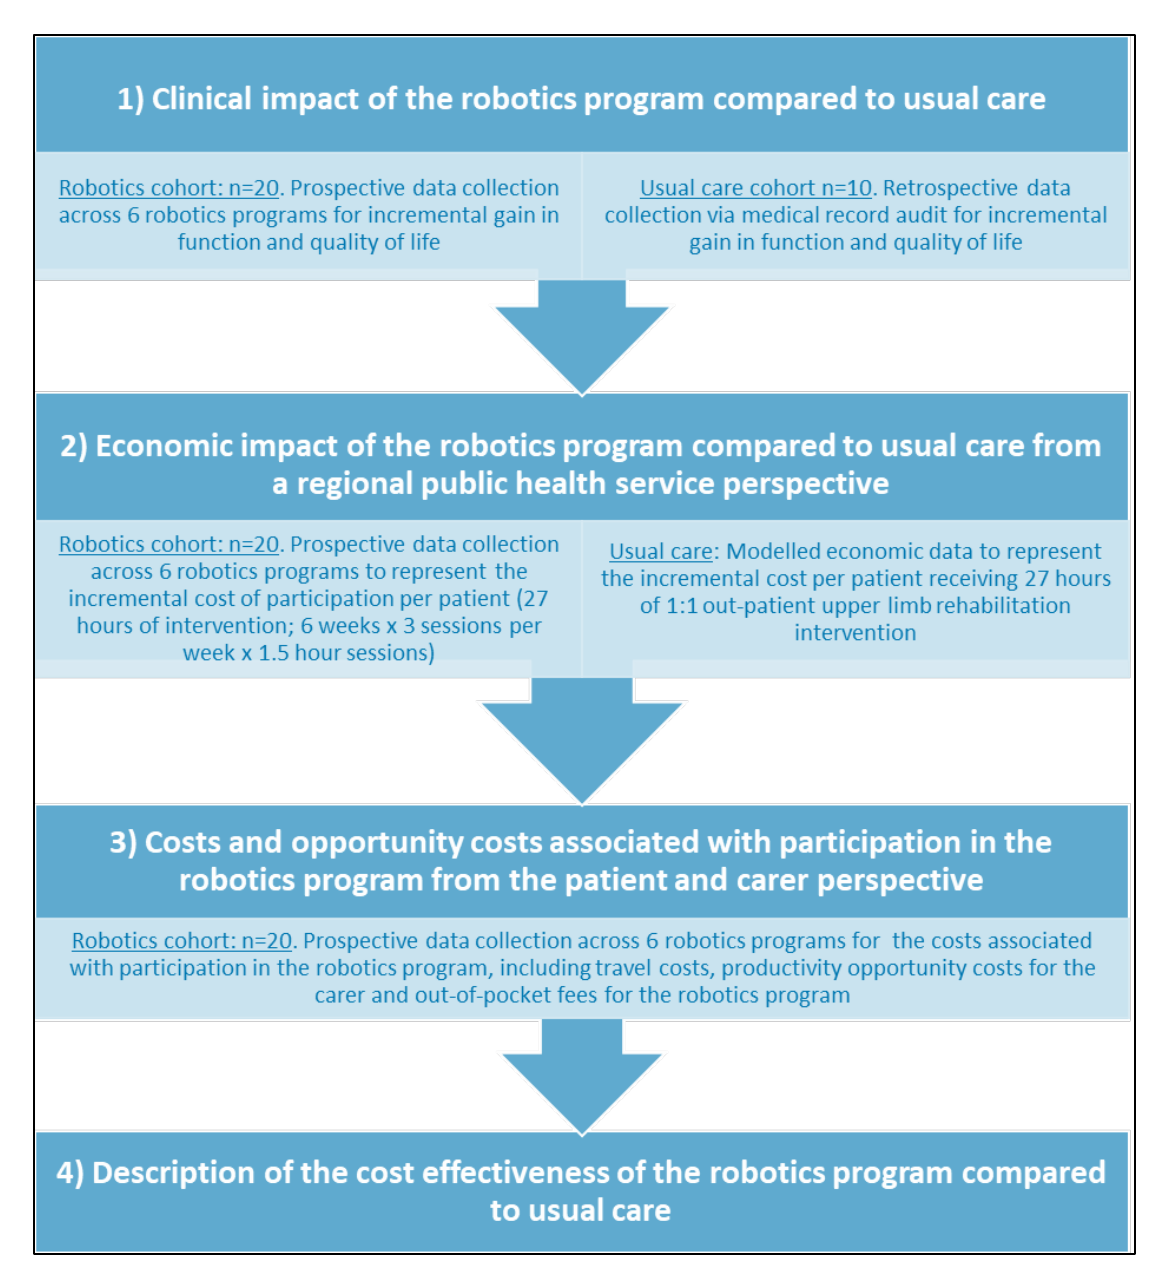
Figure 1. The four phases of the economic evaluation.